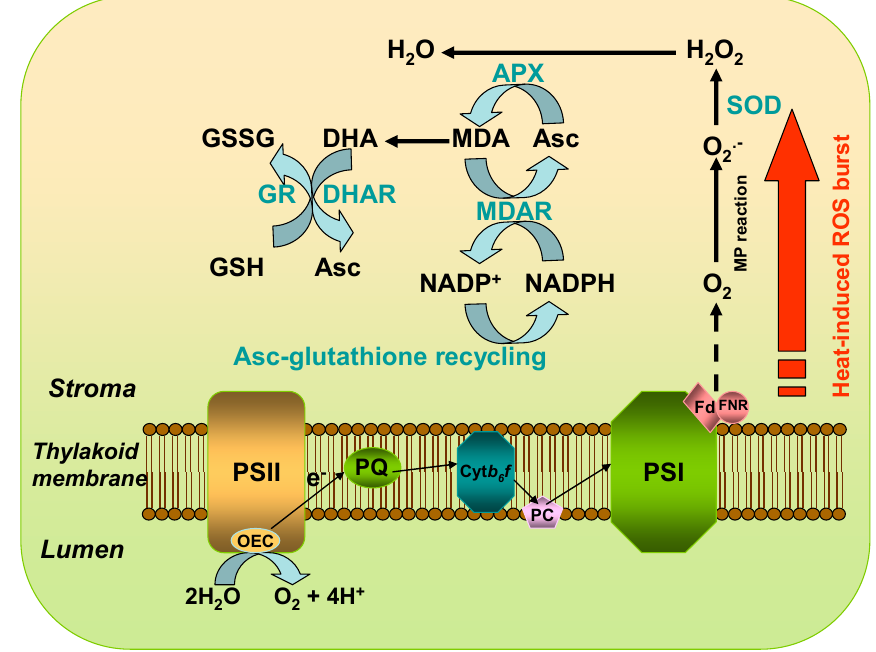
Figure 2. A representative scheme of reactive oxygen species (ROS) generation and scavenging in chloroplasts under heat stress. High temperature stress triggers oxidative bursts of superoxide and/or hydrogen peroxide in plants. The transfer of excitation energy in the photosystem II (PSII) antenna complex and the electron transport in the PSII reaction center can be inhibited by heat stress. It has been established that ROS are generated both on the electron acceptor and the electron donor side of PSII under heat stress during which electron transport from the manganese complex to plastoquinone (PQ) is limited. The leakage of electrons to molecular oxygen on the electron acceptor side of PSII forms O 2• − , inducing initiation of a cascade reaction leading to the formation of H 2 O 2 . A diversified ROS-scavenging network functions in concert in chloroplasts, mainly including antioxidants and APX-glutathione cycle, to keep the equilibrium between ROS production and scavenging. The efficient enzymatic scavenging systems are composed of several key enzymes, including superoxide dismutase (SOD), ascorbate peroxidase (APX), glutathione reductase (GR), monodehydroascorbate reductase (MDHAR), dehydroascorbate reductase (DHAR), glutathione peroxidase (GPX) and glutathione-S-transferase (GST) and non-enzymatic systems contain antioxidants such as ascorbic acid (Asc) and glutathione (GSH).